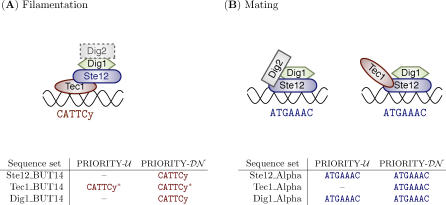
Transcriptional Complexes Involving Ste12, Tec1, and Dig1(A) During filamentation, Ste12 forms a complex with Dig1 and Tec1. Tec1 binds DNA, with a sequence specificity for CATTCy. PRIORITY-D℘N℘ finds this motif in all three sequence-sets pulled down by Ste12, Tec1, and Dig1 after the cells are treated with butanol. However, PRIORITY-U℘ misses the functional Tec1 motif in Ste12_BUT14 and Dig1_BUT14. The asterisk indicates that the learned motif is a weak match.(B) During mating, Ste12 forms two complexes: one with Dig1 and Dig2, and another with Dig1 and Tec1. In either case, it is Ste12 that binds DNA, with a sequence specificity for ATGAAAC. Again, PRIORITY-D℘N℘ finds this motif in all three sequence-sets pulled down by Ste12, Tec1, and Dig1 after the cells are treated with the alpha factor pheromone. Here, PRIORITY-U℘ fails to find the Ste12 motif in Tec1_Alpha. (Figures of the complexes are adapted from Chou et al. [25].)